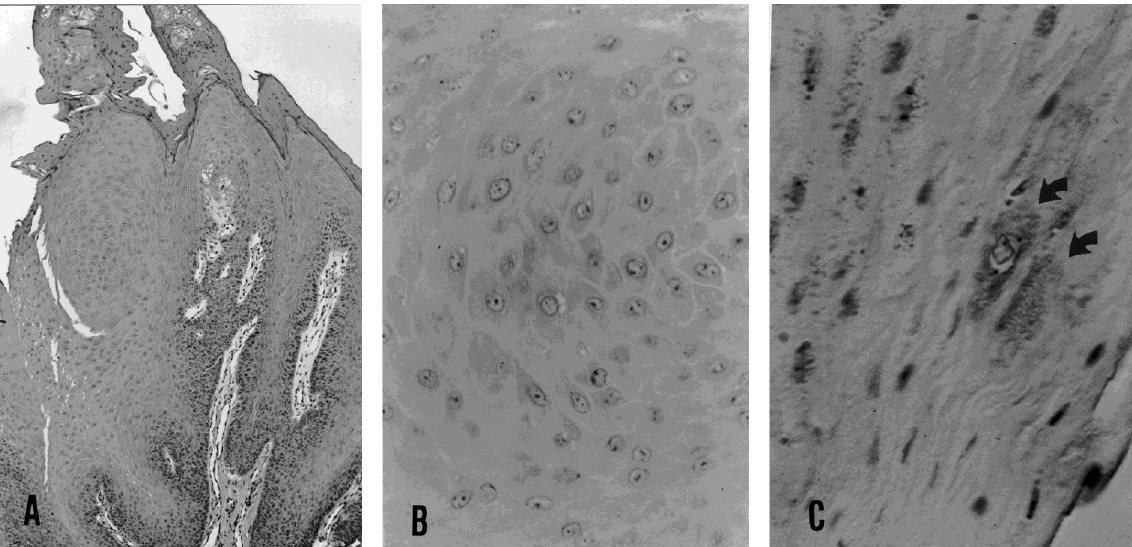
Fig. 2. Histopathological views of case 2 diagnosed as papilloma. Irregular proliferation of the epithelium was noted (A), but epithelial cells showed no atypia (B). (Hematoxylin–eosin stain (HE); original magnification × 20 (A) and × 100 (B).) (C) In situ staining of HPV antigen. The arrows show papillomavirus capsid antigens. Stained cells are koilocytes and surrounding cells. (Immunoperoxidase satin with BPV capsid antiserum; original magnification ×